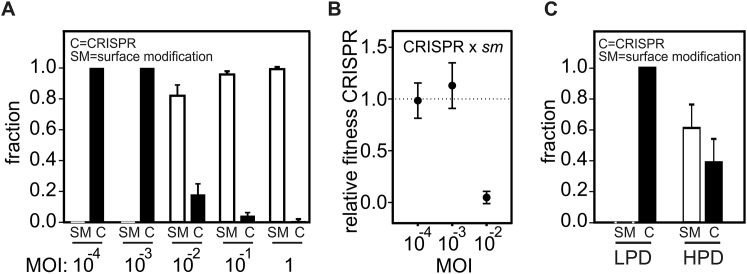
Surface Mutants Invade the Bacterial Population at High Acr-Phage Densities, Related to Figure 3(A) Resistance phenotypes (C = CRISPR resistance, SM = surface resistance) that evolved at 48 hpi with phage DMS3vir-AcrIF1 at the indicated MOIs. All bacteria in the populations initially had CRISPR resistance (2 spacers targeting the phage). Phage amplification was observed at an MOI of 10−2 or higher.(B) Relative fitness of bacteria with CRISPR resistance (2 spacers targeting the phage) and surface resistance in the presence of phage DMS3vir-AcrIF1 at the indicated MOIs.(C) Resistance phenotypes (C = CRISPR resistance, SM = surface resistance) that evolved at 48 hpi with phage DMS3vir-AcrIF1 under either high phage densities (HPD, 6 mL culture) or low phage densities (LPD, 600 mL culture). All bacteria in the populations initially had CRISPR resistance (2 spacers targeting the phage). Data correspond to the mean of 6 independent replicate experiments. Error bars represent 95% c.i.